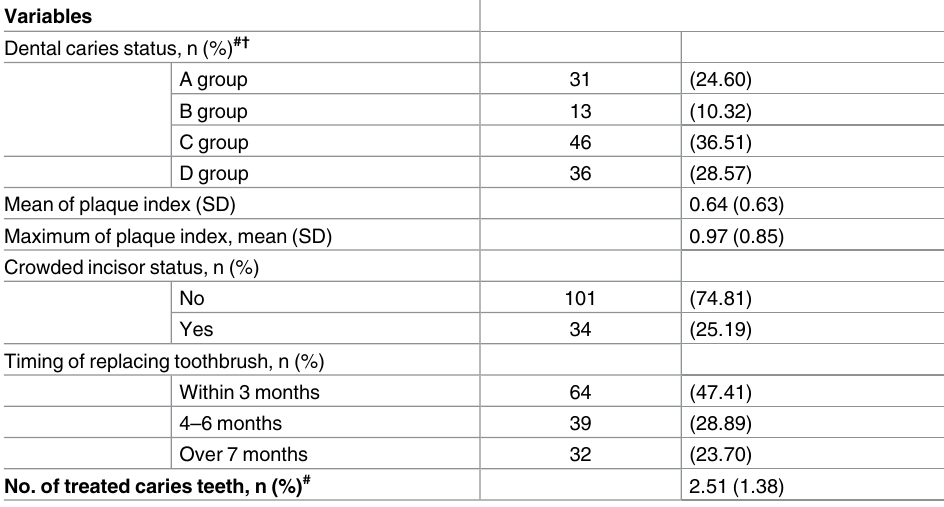
Table 2. The distribution of oral examination status, oral health behavior and treatment status (N = 135).